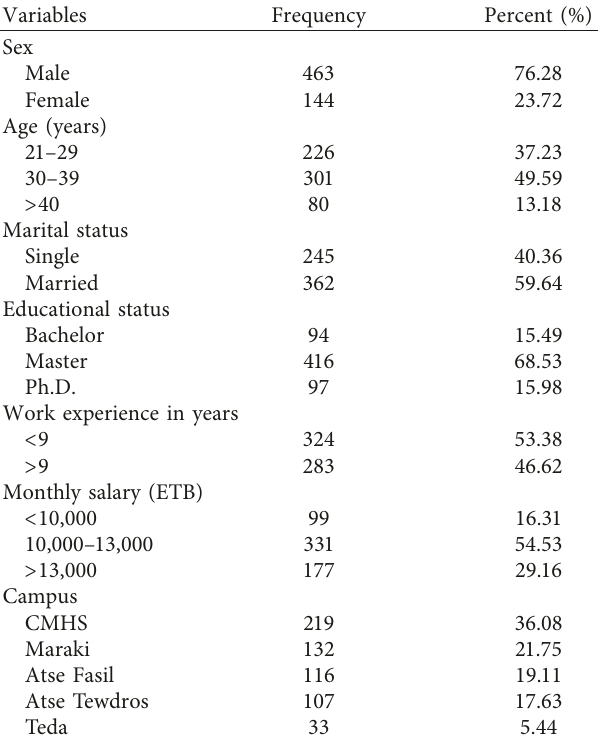
Table 1: Socio-demographic characteristics of teaching staff in the University of Gondar, Ethiopia, 2021 ( N � 607).